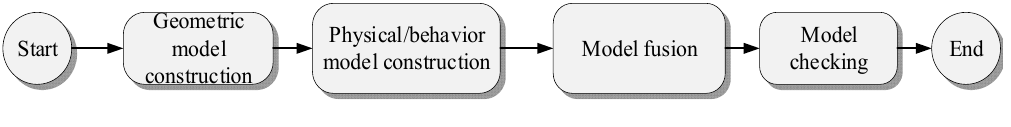
Figure 8. Design process. Figure 8. Design